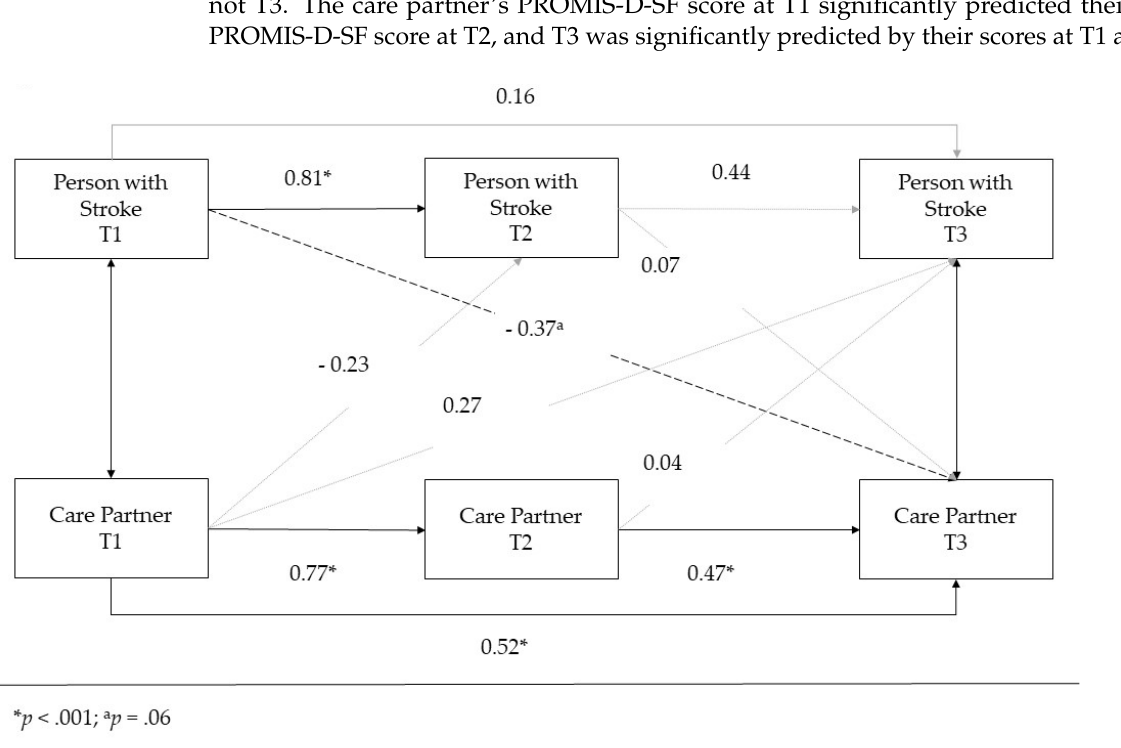
Figure 2. Simplified APIM path model . Table 4. Direct, specific indirect, and total effects for APIM analysis.